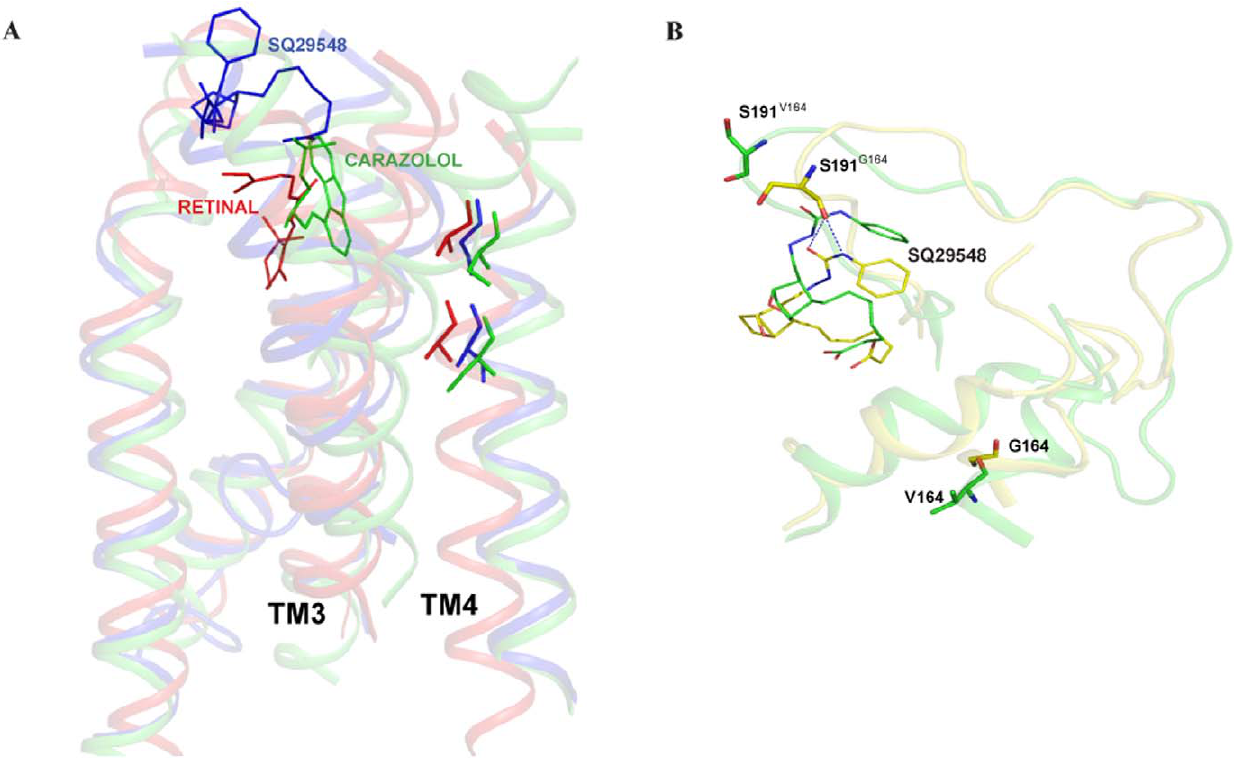
Figure 7. Molecular models of antagonist bound TP and G164V mutant and comparison with the crystal structures of rhodopsin and antagonist bound b 2 -AR. Panel A , Molecular model of TP bound SQ 29,548 superimposed with the structures of rhodopsin (PDB ID 1U19) and antagonist bound b 2 -AR (PDB ID 2RH1). The two residues at positions 4.53 and 4.57 on TM4 in both rhodopsin and b 2 -AR were previously studied. For structural comparison all the three structures were superimposed. The color coding is as follows; Ala164 and Ala168 in rhodopsin (red), Ala160 and Gly164 in TP (blue) and Ser161 and Ser164 in b 2 -AR (green). Panel B , Molecular models of TP (yellow) and G164V (green) superimposed. The important amino acids Gly164, Val164 and Ser191 are shown. Notice that Ser191 loses interaction with the antagonist SQ 29,548 in the G164V mutant.